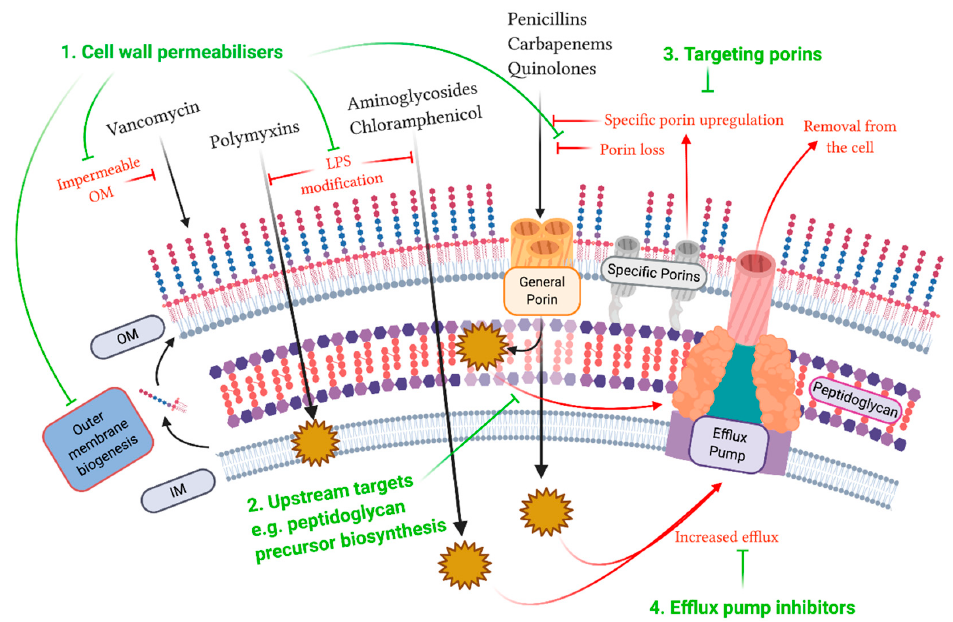
Figure 3. Novel Approaches to Bypass Resistance Mechanisms. Shown in green are the potential approaches for overcoming antibiotic resistance mechanisms associated with the cell wall in